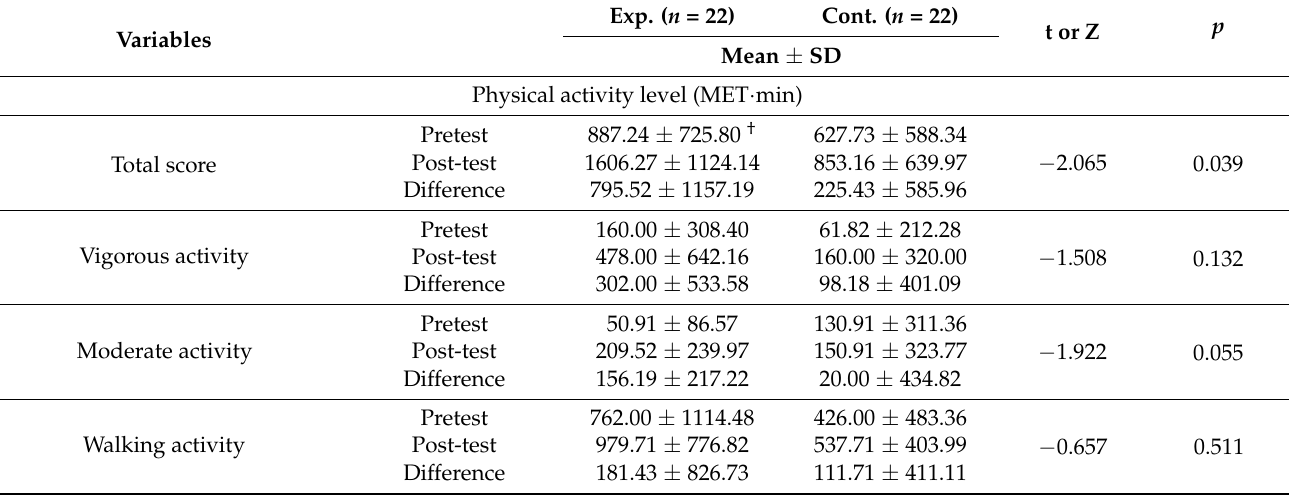
Table 3. Between-group differences of outcome variables after intervention ( N =